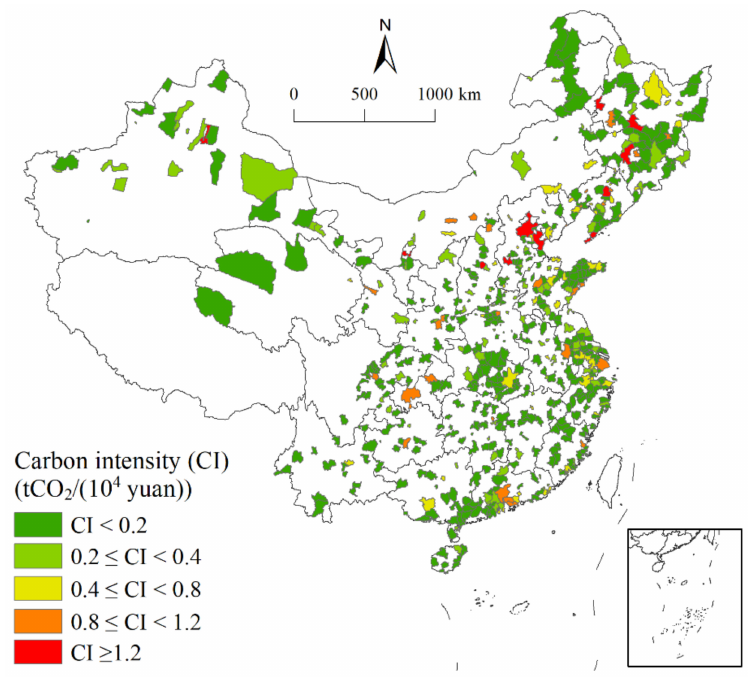
Figure 1. Spatial distribution of carbon intensity during 2001–2015.